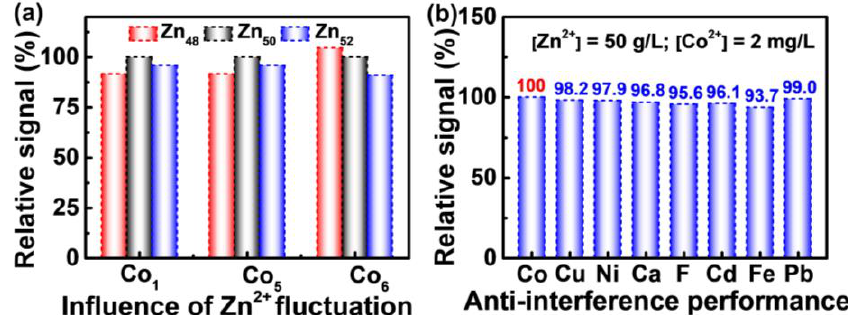
Figure 4. ( a ) Effect of Zn 2+ concentration fluctuation on Co 2+ response signal. ( b ) The influence of interfering ions: [Zn 2+ ] = 50 g/L, [Co 2+ ] = 2 mg/L, [Cu 2+ ] = 0.5 mg/L, [Ni 2+ ] = 1 mg/L, [Ca 2+ ] = 800 mg/L, [F - ] = 50 mg/L, [Cd 2+ ] = 0.1 mg/L, [Fe 2+ ] = 2 mg/L, [Pb 2+ ] = 0.05 mg/L. The Y- axis “Relative signal (%)” represents the relative values of absorbance ratio between reference and experimental values ((A 533 /A 393 ) ref /(A 533 /A 393 ) exp ): ( a ) 50 g/L Zn 2+ was set as reference, and 48 g/L and 52 g/L as the experimental group; ( b ) the mixture of 50 g/L Zn 2+ and 2 mg/L Co 2+ was set as reference, a third metal ion introduced into the Zn−Co mixture system was set as the experimental group.